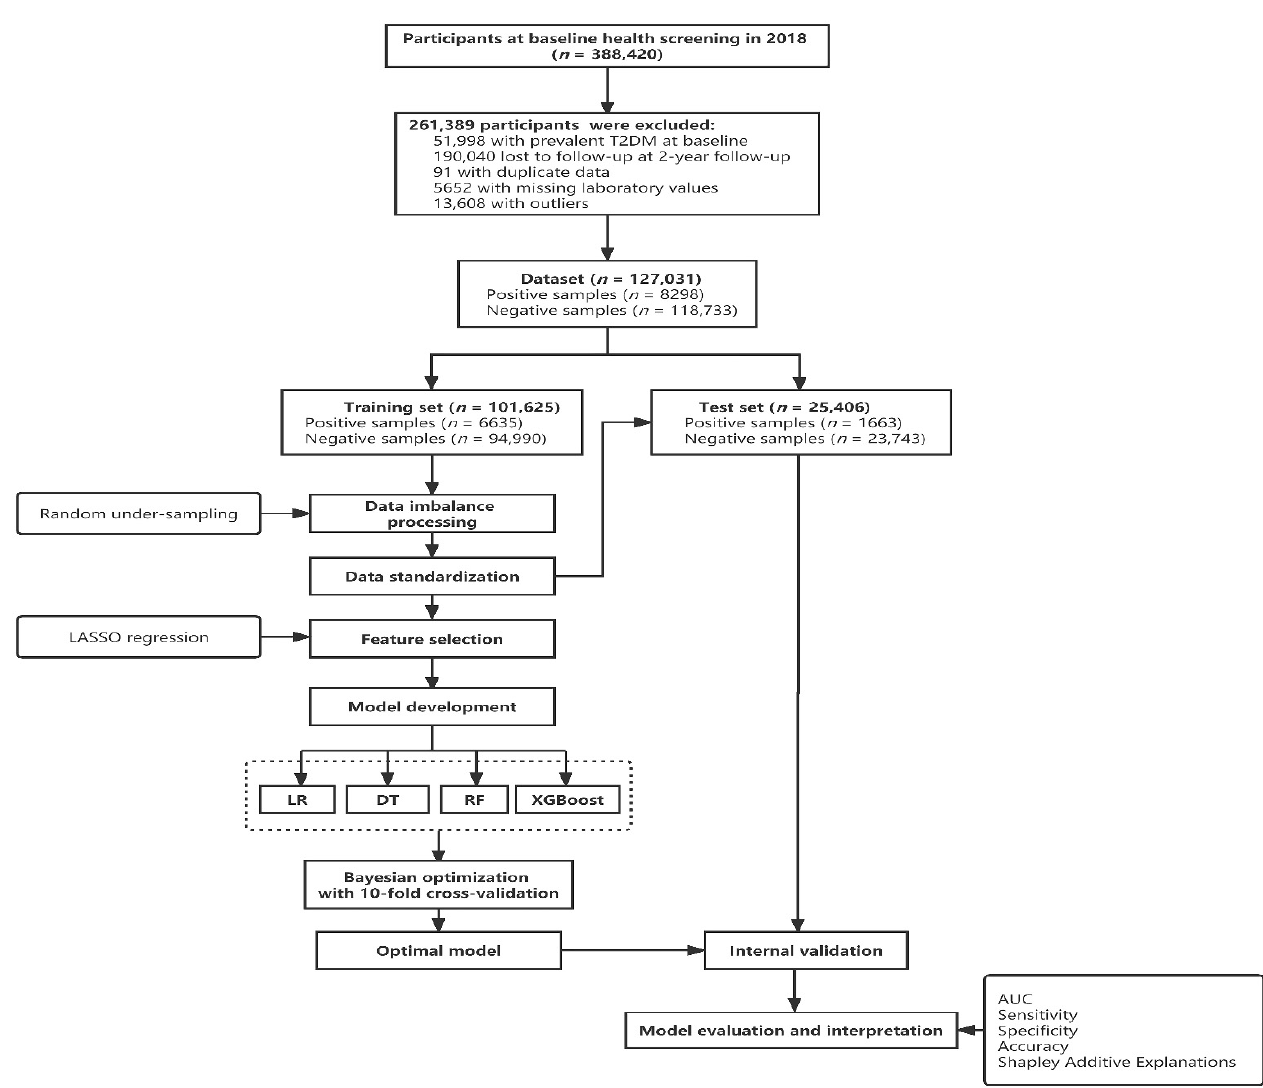
Figure 1. The study flow chart. LR, logistic regression; DT, decision tree; RF, random forest; XGBoost, extreme gradient boosting; LASSO, least absolute shrinkage and selection operator.